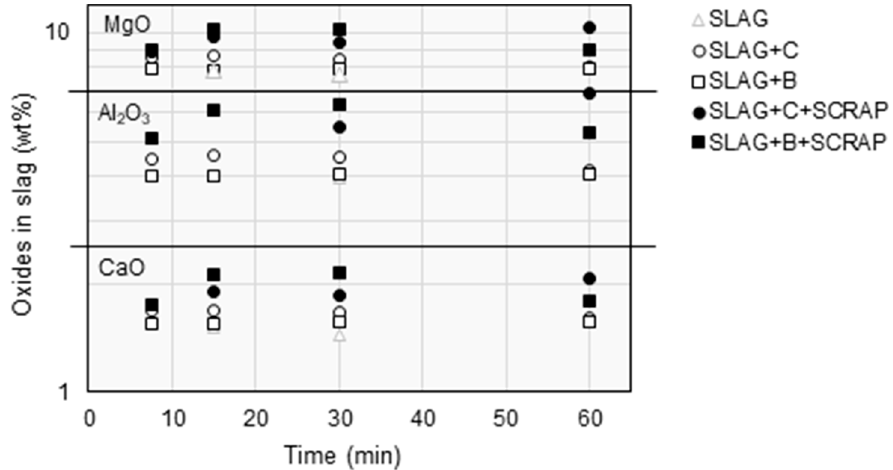
Figure 3. CaO, Al 2 O 3 and MgO concentrations in slags as a function of reduction time at 1400 ◦